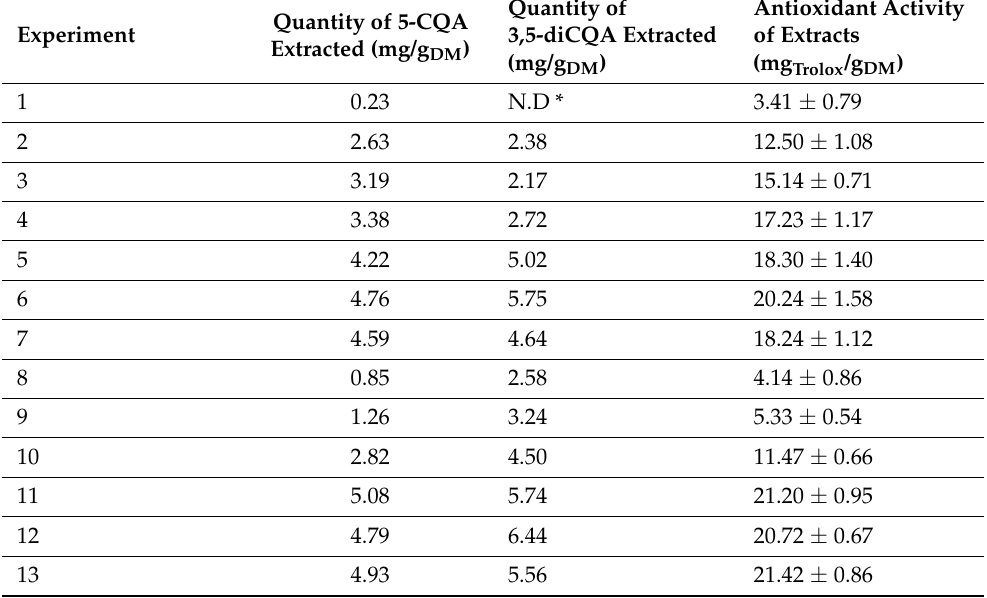
Table 3. Experimental